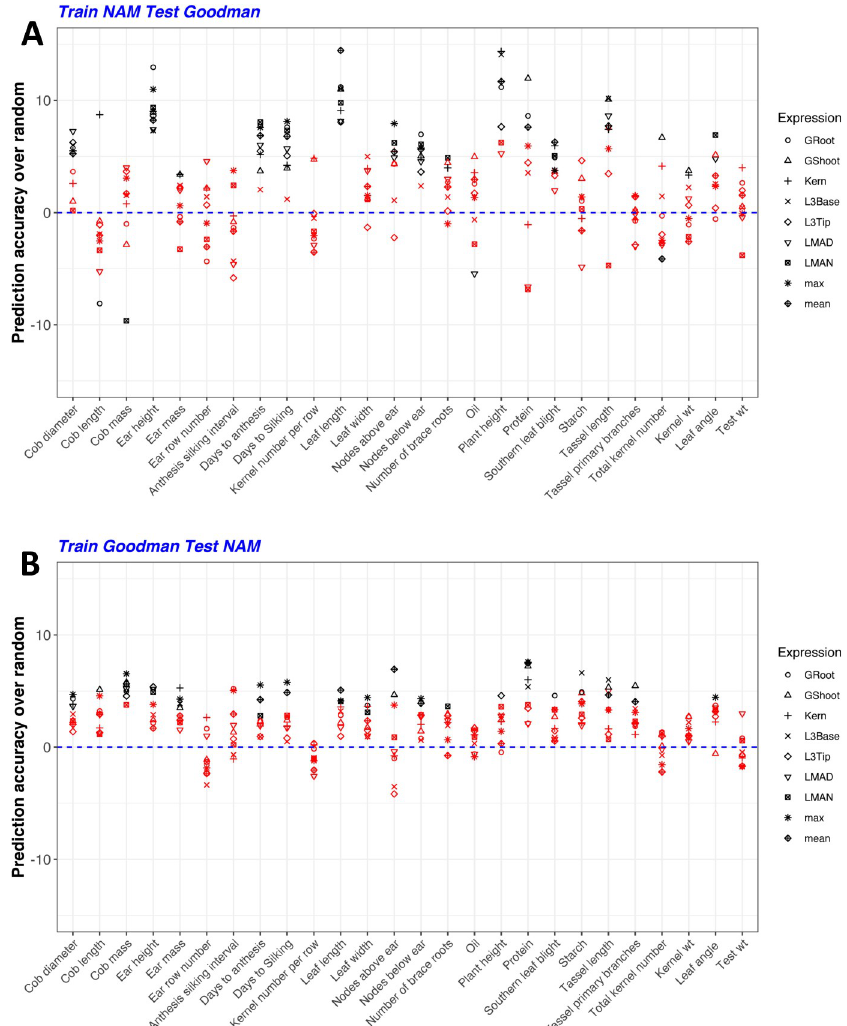
Fig 6. HARE improved cross-panel prediction accuracy over random expression values for most of the traits. Change in prediction accuracy using HARE over the mean accuracy from random HARE (blue dashed line) for models (A) trained in NAM and tested in the Goodman panel, (B) trained in the Goodman panel and tested in NAM. The different symbols represent HARE from different tissues: germinating seedlings root (GRoot), germinating seedlings shoot (GShoot), 2 cm from the base of leaf 3 (L3Base), 2 cm from the tip of leaf 3 (L3Tip), mature mid-leaf tissue sampled during mid-day (LMAD), mature mid-leaf tissue sampled during mid-night (LMAN), and developing kernels harvested after 350 growing degree days after pollination (Kern). The black shapes represent statistically significant differences at P-values < 0.05 and red shapes represent no statistical significance. P-values were calculated using a Monte Carlo